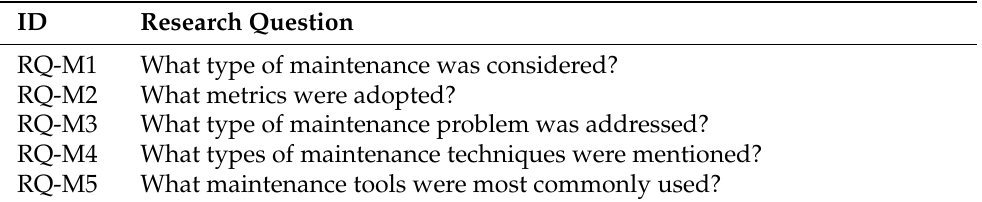
Table 2. Research questions on